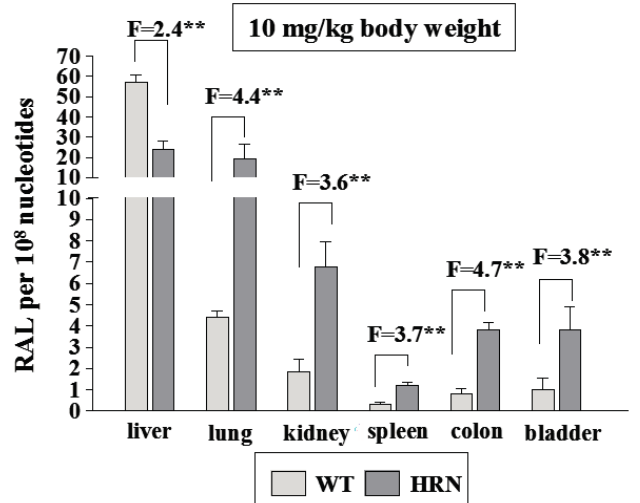
Figure 5. Total levels of ellipticine-DNA adducts determined and quantified by 32 P-postlabelling analysis of DNA isolated from organs of HRN and WT mice treated i.p. with 10 mg ellipticine/kg body weight. F = fold higher and/or lower DNA adducts in HRN than WT mice. Columns, mean; bars, SD ( n = 3); each DNA sample was analysed twice. ** p < 0.01. RAL, relative adduct